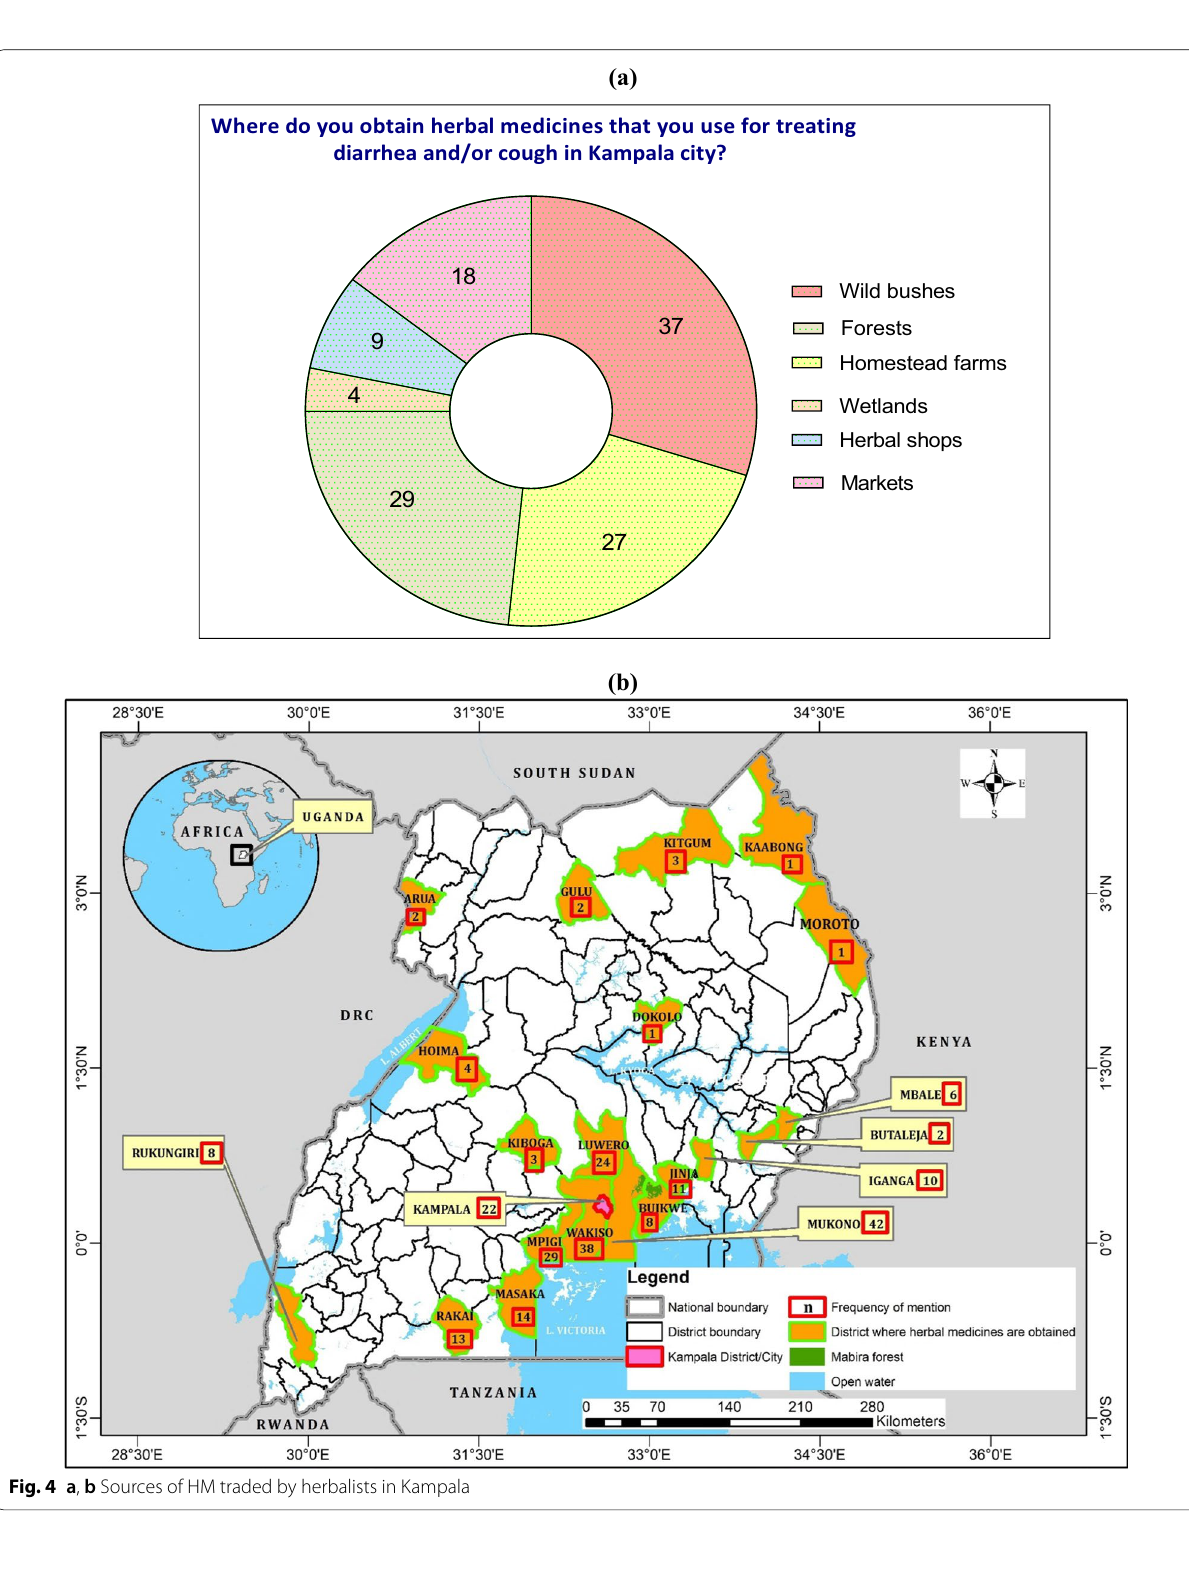
Fig. 4 a , b Sources of HM traded by herbalists in